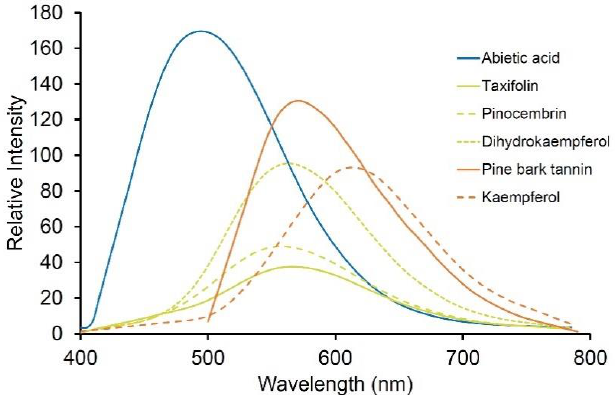
Figure 8. Fluorescence spectra of some common purified wood extractives (from Sigma except for pine bark tannin manufactured by Scion) showing relative brightness [14]. Excitation was at 355 nm except for pine bark tannin which was excited at 488 nm.